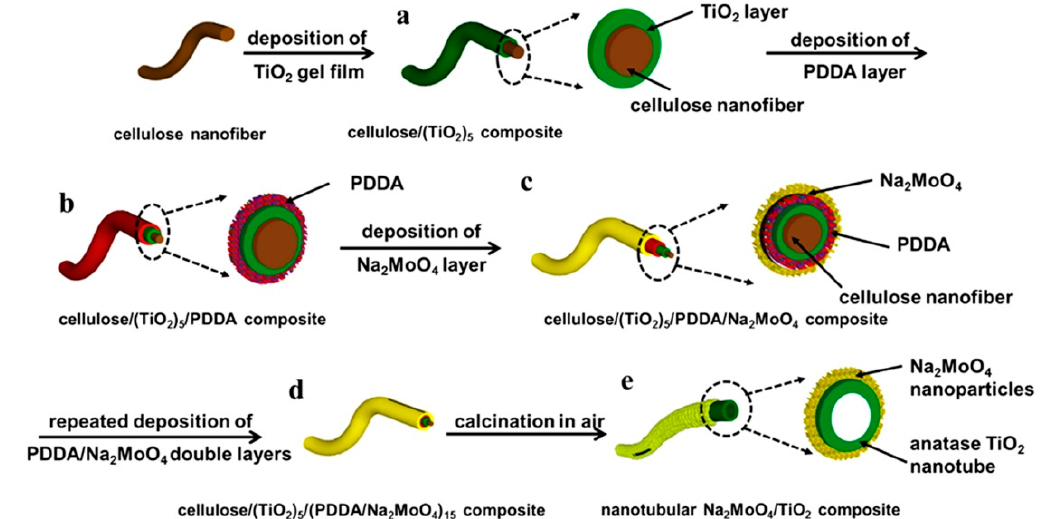
Scheme 1. Schematic illustration of the synthetic processes for the nanotubular Na 2 MoO 4 /TiO 2 composite derived from natural cellulose substance. ( a ) The titania – cellulose-nanofiber composite was prepared by the surface sol-gel process. ( b ) The PDDA/titania/cellulose-nanofiber composite was obtained by depositing the PDDA layer onto the titania – cellulose-nanofiber composite surface. ( c ) The Na 2 MoO 4 /PDDA/titania/cellulose-nanofiber composite was prepared